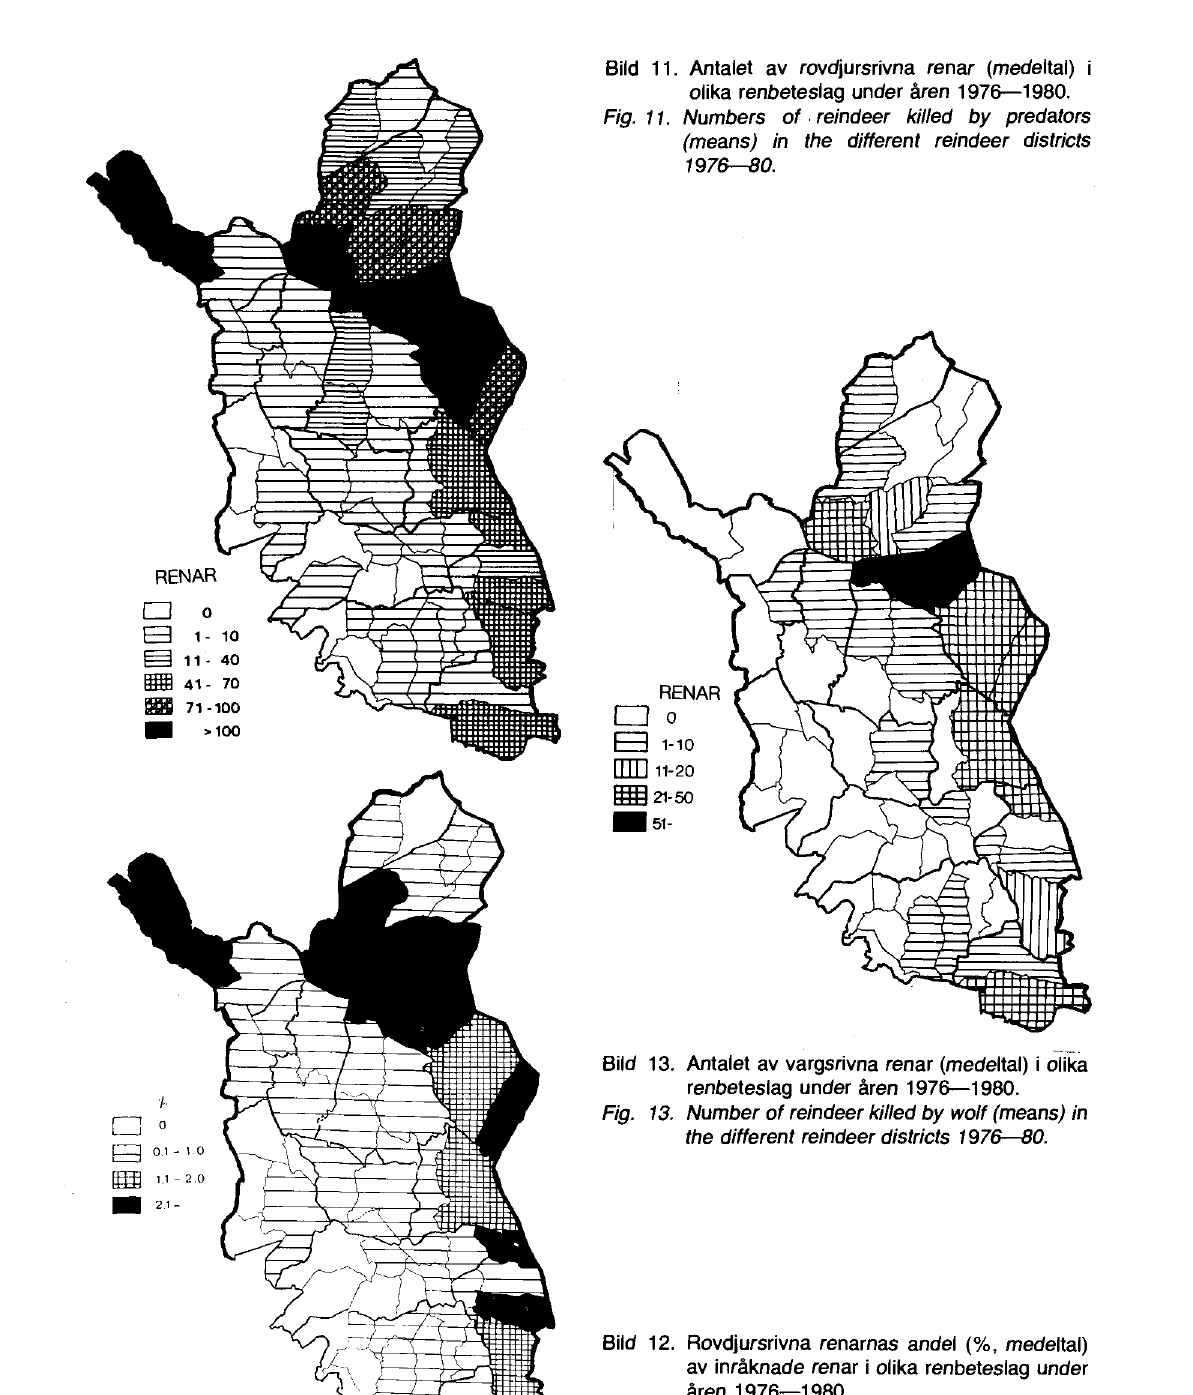
Bild 12. Rovdjursrivna renarnas andel (%, medeltal) av inråknade renar i olika renbeteslag under åren 1976—1980. Fig. 12. Numbers of reindeer killed by predators in % (means) of total reindeer stock in the different reindeer districts